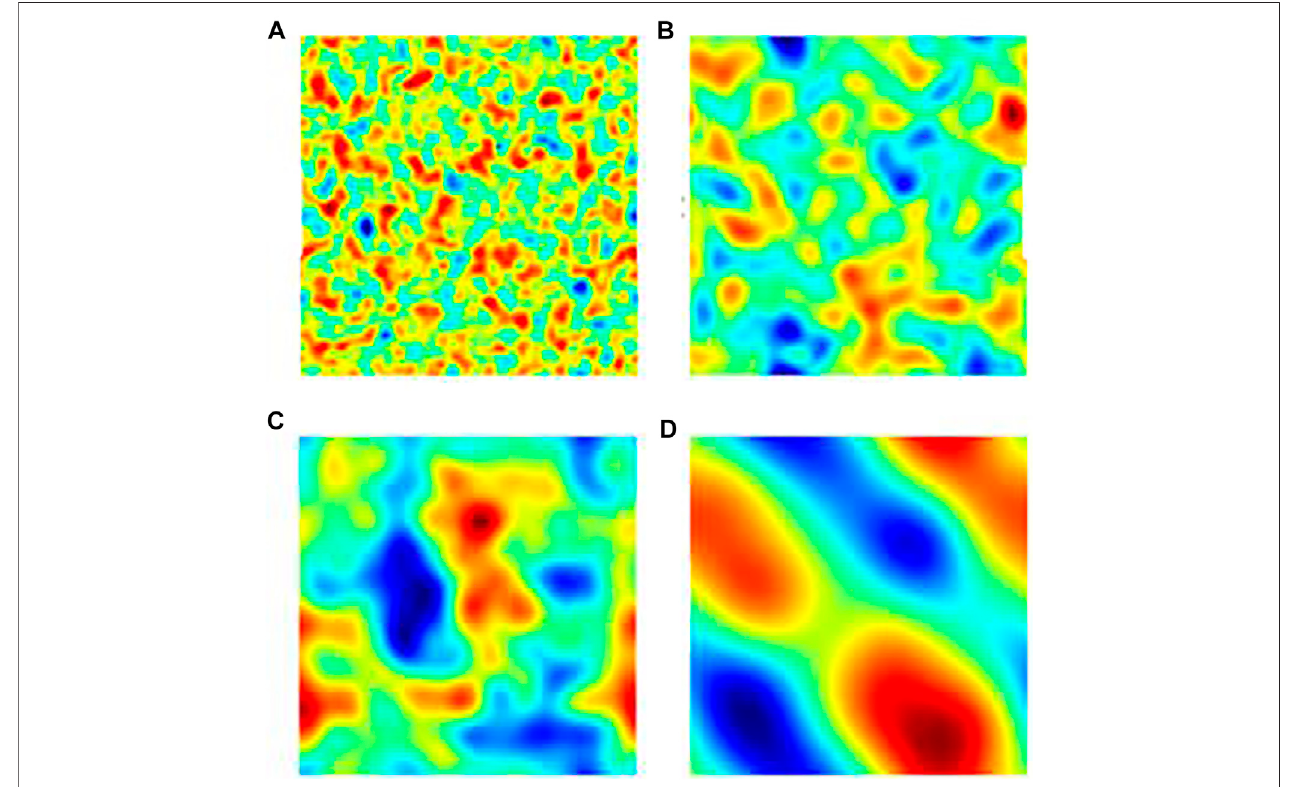
FIGURE 1 | Density fi elds under isothermal conditions for phase separation procedures with ρ p (cid:2) 1.2 and τ p (cid:2) 1 using the interactive strengths with G (cid:2) − 1 at four times: (A) 100 ts, (B) 200 ts, (C) 300 ts, and (D) 1800 ts.